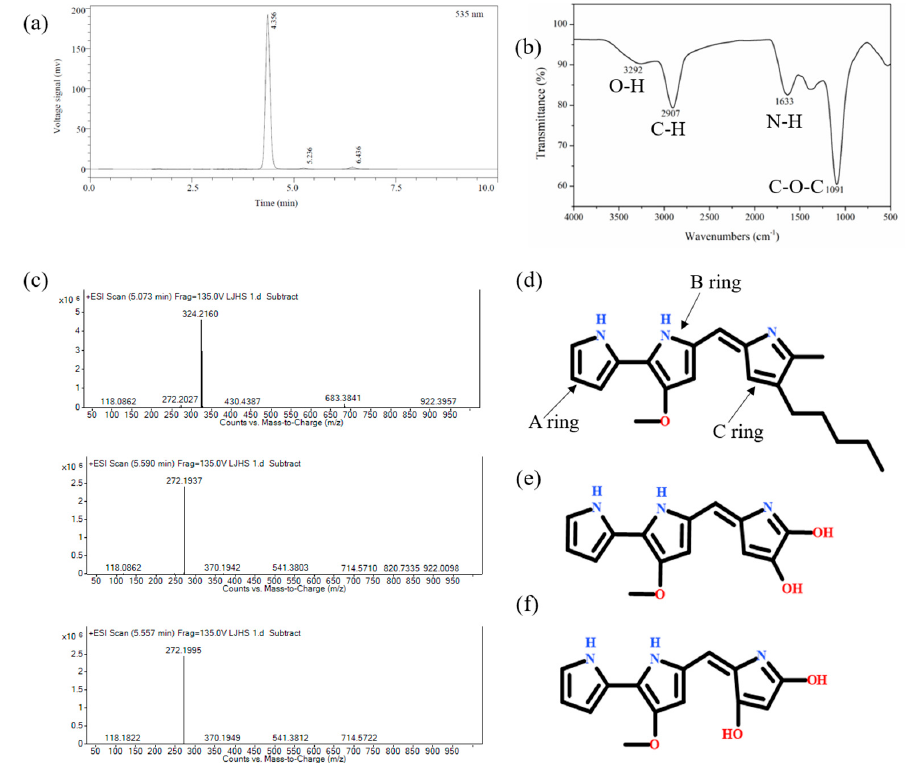
Figure 3. Spectral analysis of the red pigment in the fermentation broth. ( a ) Infrared spectrum, ( b , c ) HPLC-MS of crude prodigiosin. ( d – f ) Structure prediction of the metabolites based on HPLC-MS. Structure of the main product ( d ) and the two by ‐ products ( e , f ).